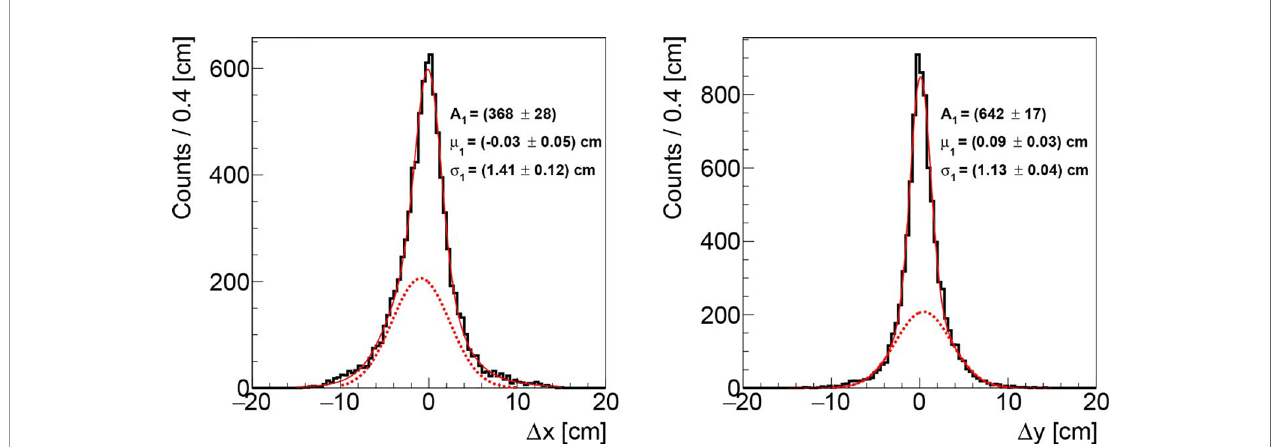
FIGURE 5 | Distributions of the differences between the measured and the actual beam transverse position, respectively in the x (left) and y (right) axis, obtainded analysing the data acquired during the fi rst fraction of PZC. The solid, red line represents the overall fi t function while the dotted, red line highlights the tail